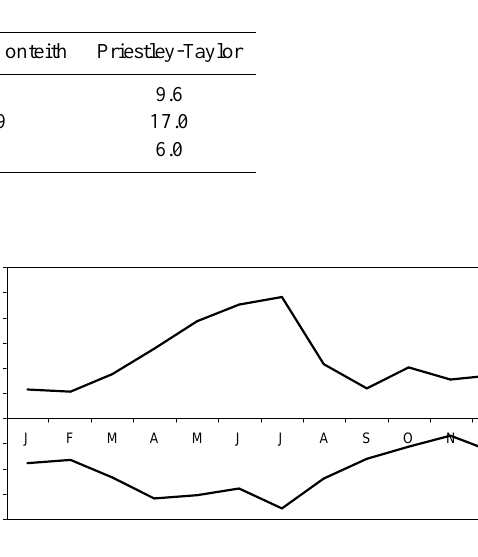
Figure 10 Fig. 10. Model parameter uncertainty in River Mitano discharge under the HadCM3 2 ◦ C scenario: maximum extent of the disparity between the scenario-baseline difference in the perturbed parameter versus reference model